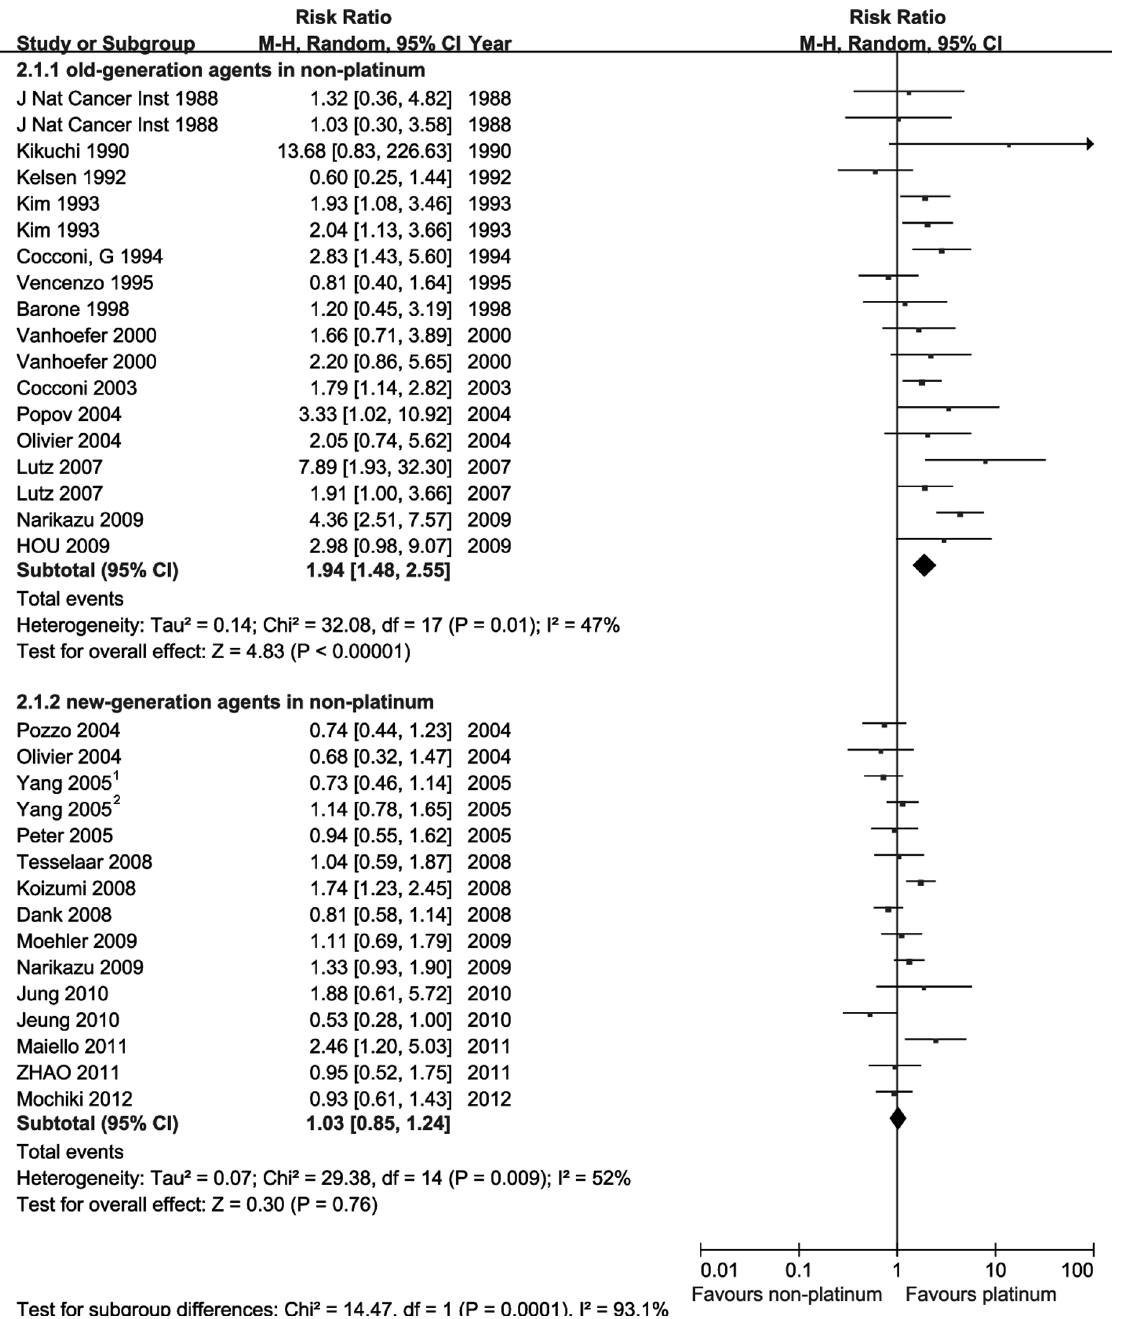
Figure 2. Comparison of response rate between platinum-based therapy and nonplatinum-based therapy. Subgroups were stratified according to whether the non-platinum contained new-generation agents such as S-1, taxanes or irinotecan.